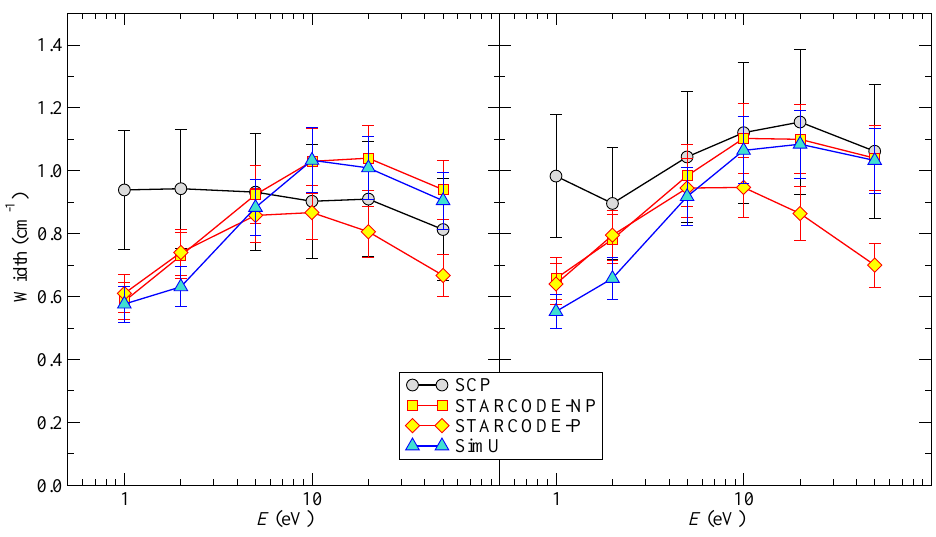
Figure 1. Li I 2 s − 2 p FWHM as a function of the energy E . ( Left ) the dipole interaction is only taken into account; ( Right ) the dipole and quadrupole interaction are both taken into account.